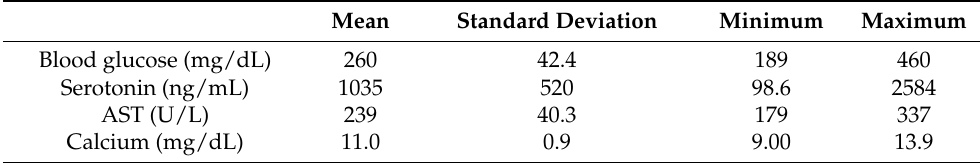
Table 1. Serum biochemical parameters measured at exsanguination of broilers. Mean Standard Deviation Minimum Maximum Blood glucose (mg/dL) 260 42.4